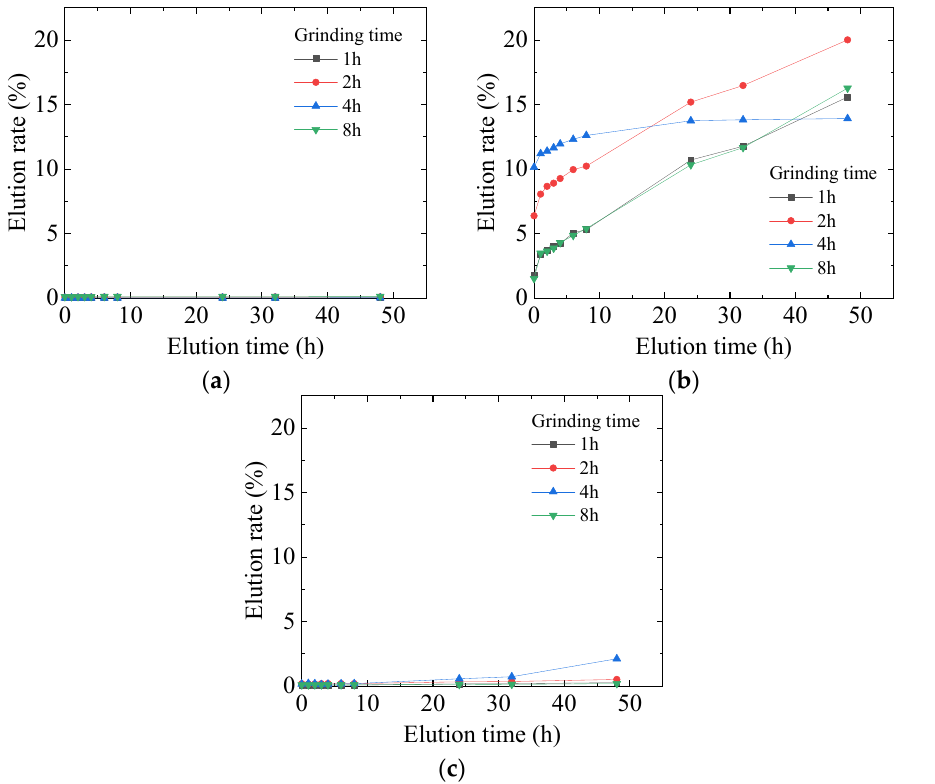
Figure 3. Elution rate of ( a ) As, ( b ) Cu and ( c ) Fe from wet ground samples at different grinding times.